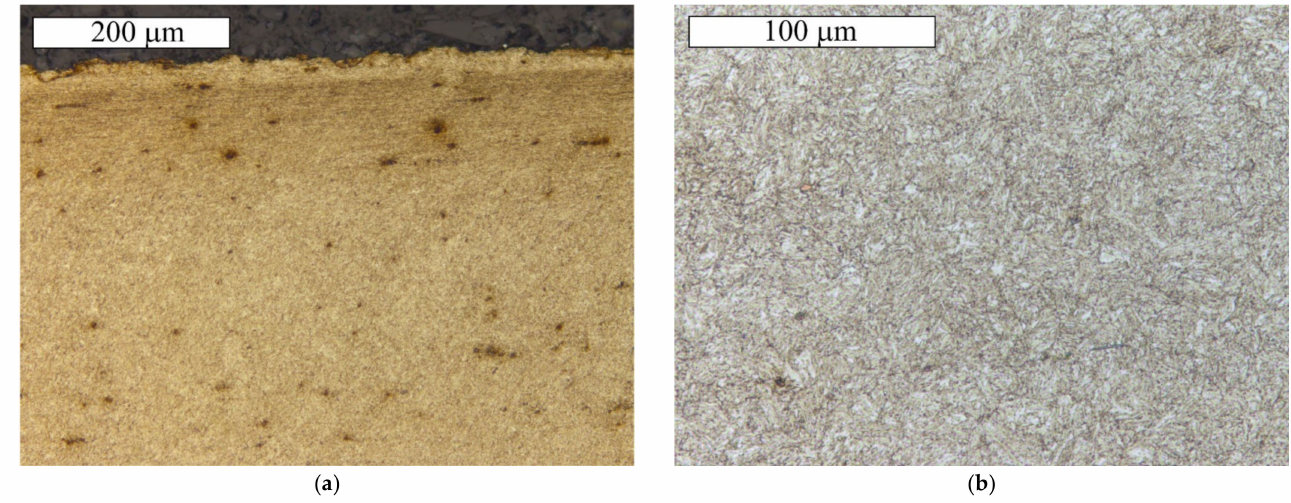
Figure 10. The longitudinal section of the threaded part of the S1 bolt in the surface location: ( a ) Visible martensitic microstructure and a strong plastic deformation of the surface, ( b ) Martensitic microstructure in the core. Etched state, Light